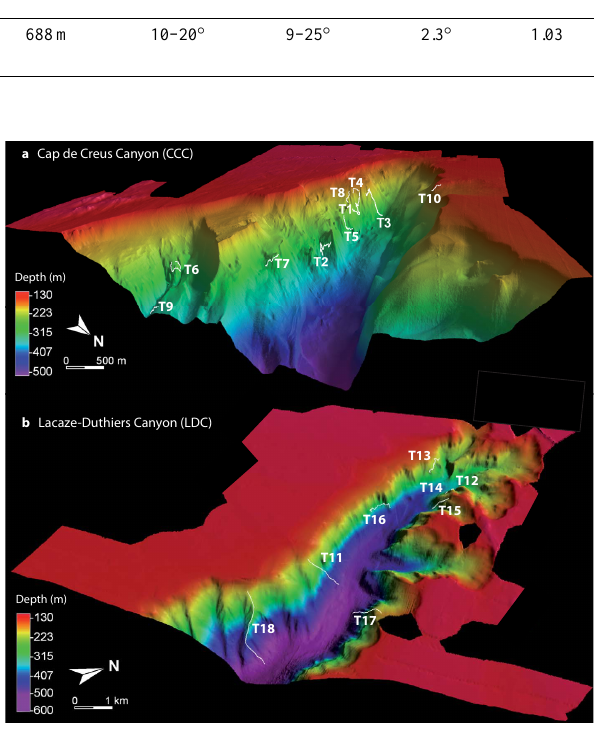
Fig. 2. Three-dimensional bathymetry illustrating the locations of the video tracks (T1 to T18) in (a) the Cap de Creus Canyon (CCC) and (b) the Lacaze-Duthiers Canyon (LDC). The CCC bathymetry was acquired by Fugro Survey, AOA Geophysics and the Univer- sitat de Barcelona in 2004 with the hull-mounted Kongsberg Sim- rad EM300 30kHz system, emitting 135 equidistant beams spaced every 1.0degrees. Data were processed using Kongsberg’s NEP- TUNE software, and gridded with a cell size of 10 × 10m. The LDC bathymetry was acquired in 1997 by IFREMER (P. I. Serge Bern ´ e) with the hull-mounted Kongsberg Simrad EM12D 13kHz dual system, emitting 162 beams spaced from 1.0 to 1.5degrees. Data were processed using IFREMER’s CARAIBES software, and gridded with a cell size of 20 ×